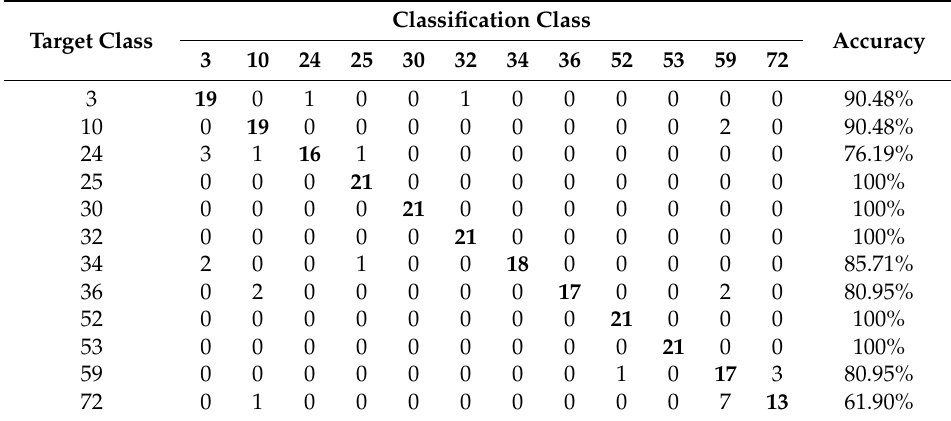
Table 6. Confusion matrix of true classification of ECG beat data of person.